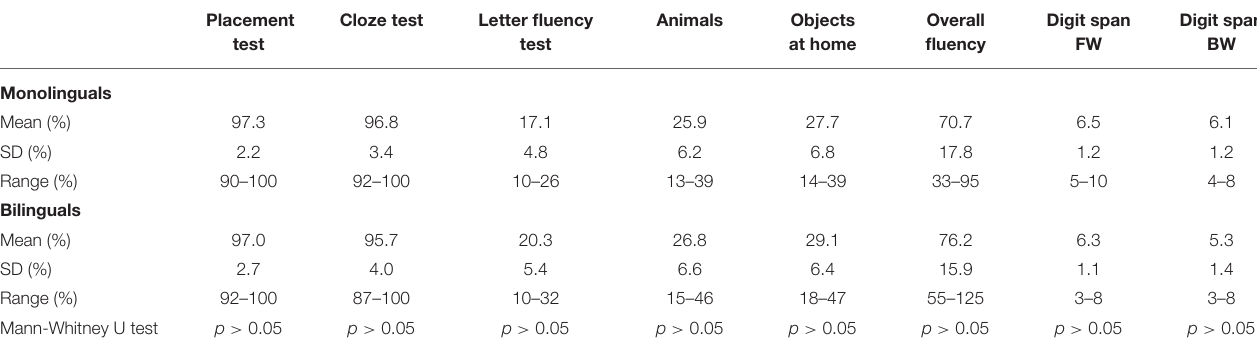
TABLE 2 | Participants’ German